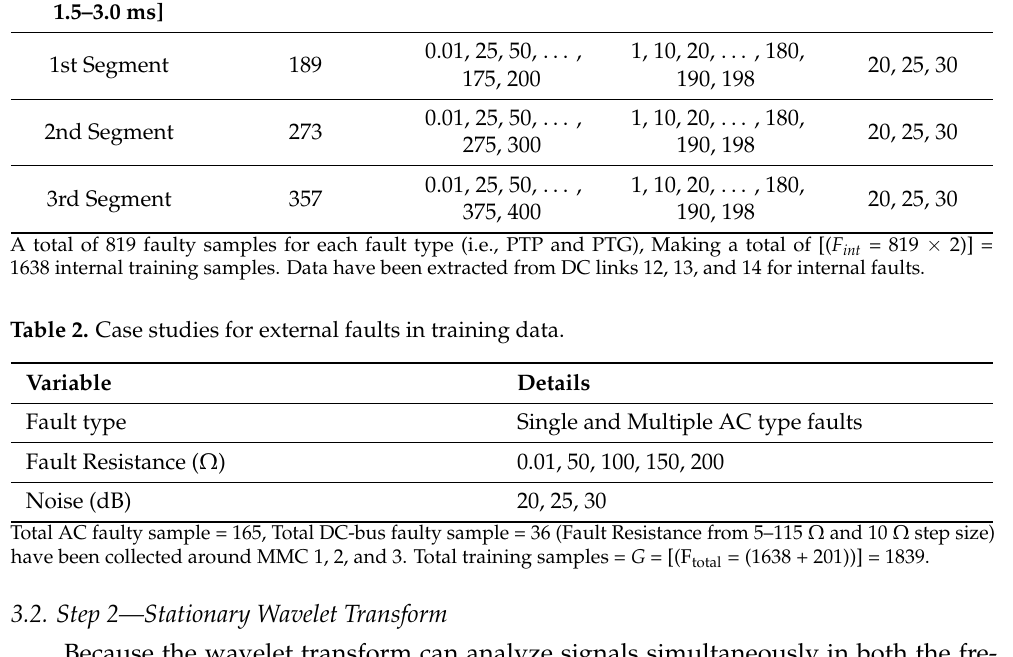
Table 2. Case studies for external faults in training data .